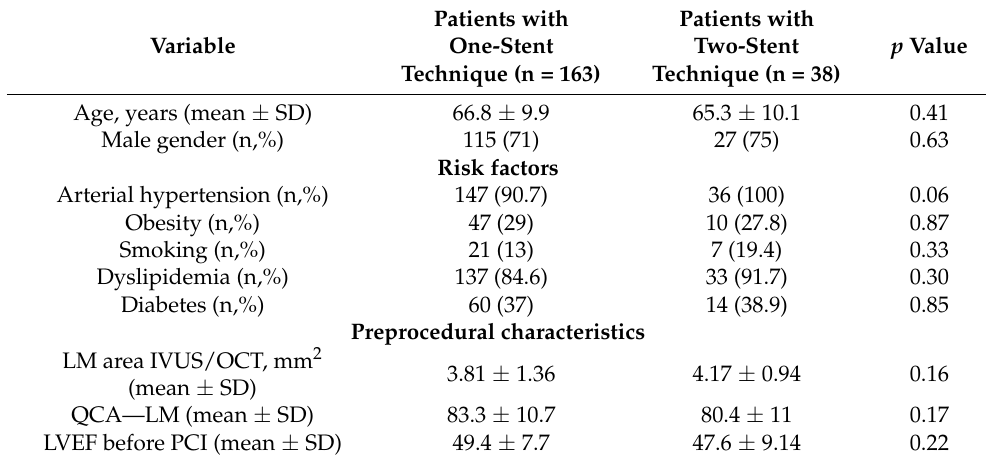
Table 2. Differences between characteristics of the patients according to the one- or two-stent